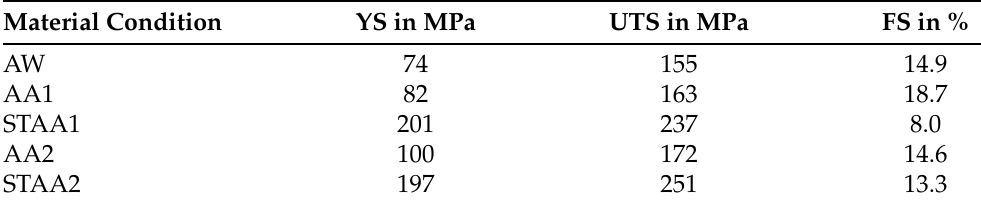
Table 5. The median values of YS, UTS and FS for the longitudinal tensile specimens. Material